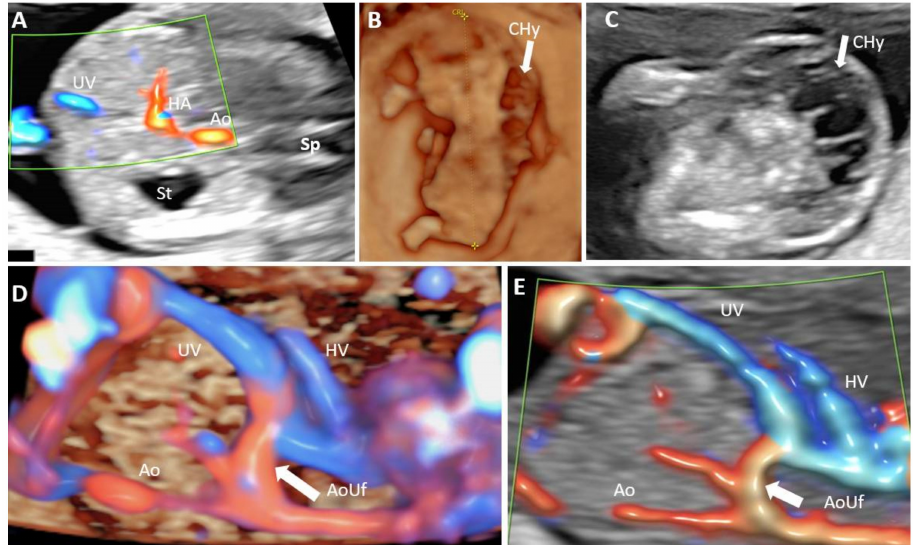
Figure 4. Absence of the portal system in a first trimester case associated with hygroma and aorto- umbilical fistula. ( A ): Transverse plane of the upper abdomen with color Doppler applied, showing umbilical cord insertion, stomach, the prominent hepatic artery and no afferent liver venous perfusion; ( B ): midsagittal plane reconstructed from a three-dimensional volume acquisition were the crown- rump length is measured and fetal cystic hygroma can be observed (white arrow); ( C ): transverse sonographic view of the neck showing the septated nuchal cystic mass (white arrow); ( D ): 4D STIC showing in the longitudinal view of the fetal abdomen an abnormal connection (white arrow) between umbilical vein and aorta. ( E ): same aspects as ( D ), using two dimensional color Doppler assessment. UV umbilical vein, HA hepatic artery, Ao aorta, St stomach, Sp spine, CHy cystic hygroma, AoUf aorto-umbilical